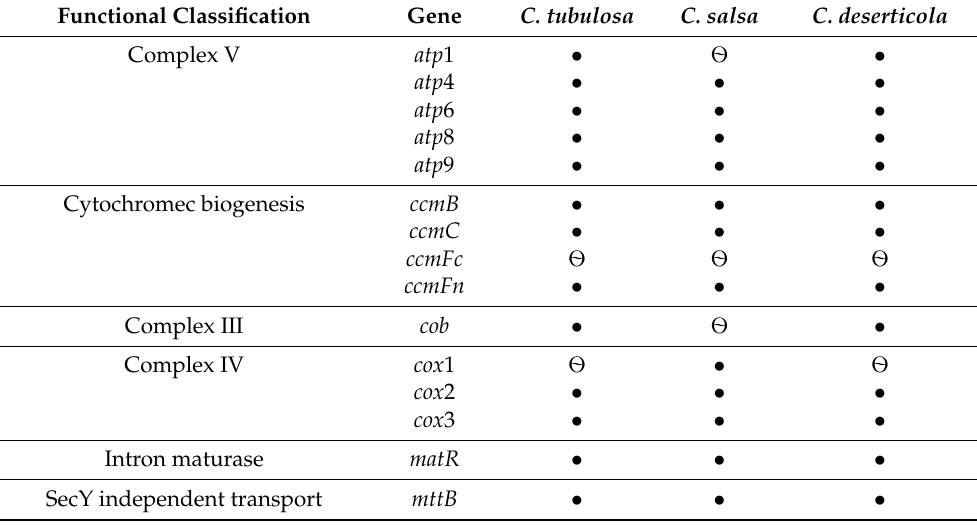
Table 2. Protein-coding genes in Cistanche species mitogenomes. • : no intron containing gene present; Ө : trans-spliced gene present; : cis-spliced gene present; Ψ : pseudogene present; × : gene absent. (cid:35) Functional